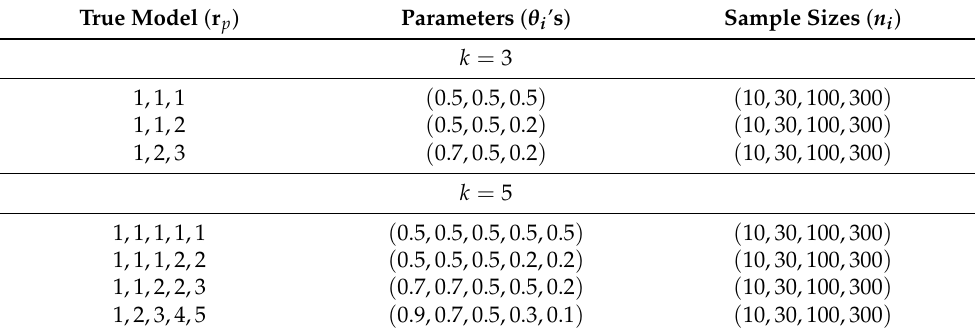
Table 1. Parameters for the simulation